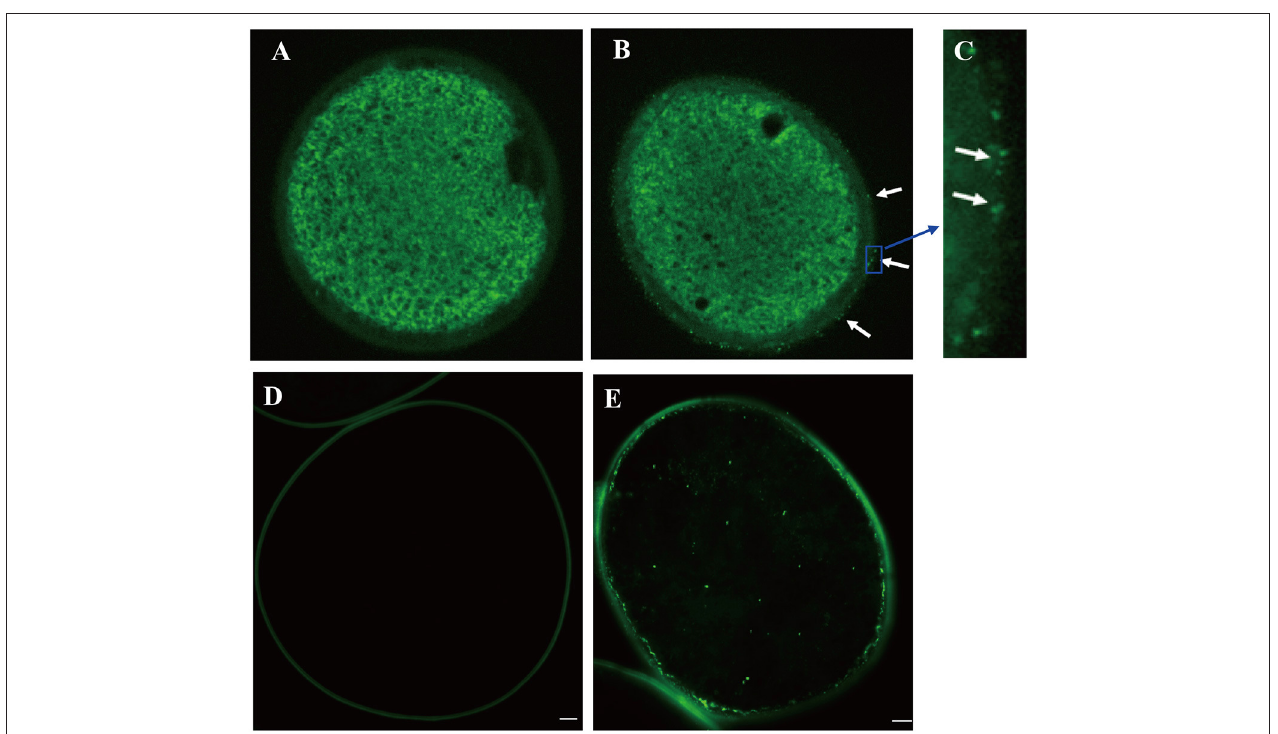
FIGURE 8 | Localization of ZmCP03 in maize pollen by immunofluorescence microscopy. (A) Control without primary antibody, no signal is detected; (B) in the presence of primary antibody, several fluorescent dots can be seen on the surface of pollen grains (arrows); (C) a magnification picture of (B) highlighting some dots on the grain surface; (D) sections of maize pollen without a primary antibody; (E) sections of maize pollen with a primary antibody. Maize pollen sections were probed with (B,D) anti-CP (1:200 dilution, 4 ◦ C, overnight) or (A,D) negative control, and then incubated with fluorescence anti-rabbit lgG (1:100, 37 ◦ C, 45min). Scale bar = 5 µ